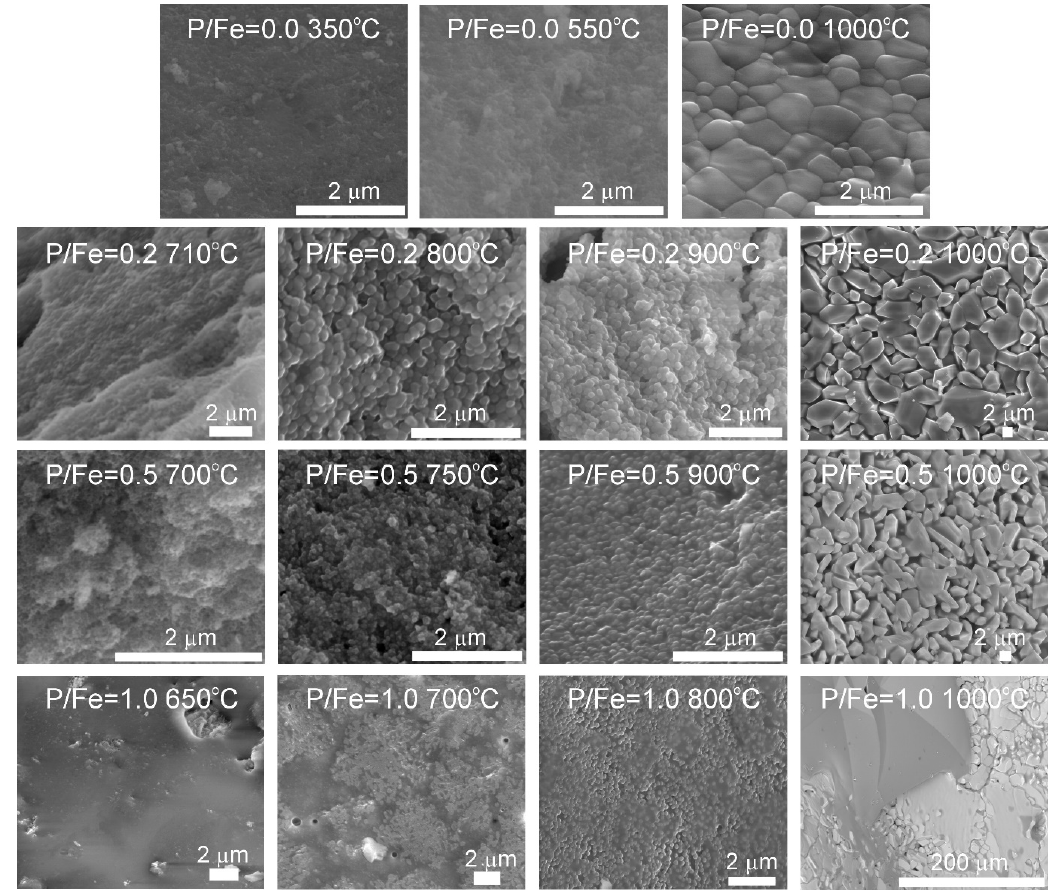
Figure 9. Comparison of morphologies of P-doped ferrihydrites heated to various temperatures and final products annealed at 1000 °C (SEM, secondary electron micrographs).